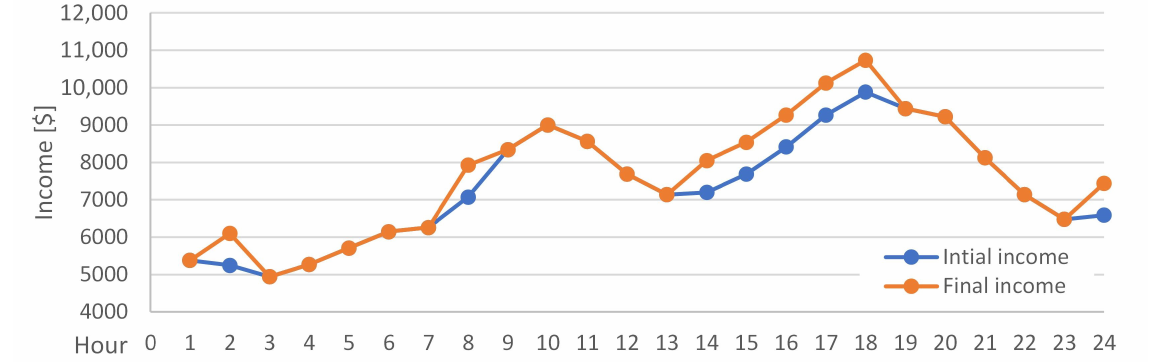
Figure 8. Distribution of income of DG.